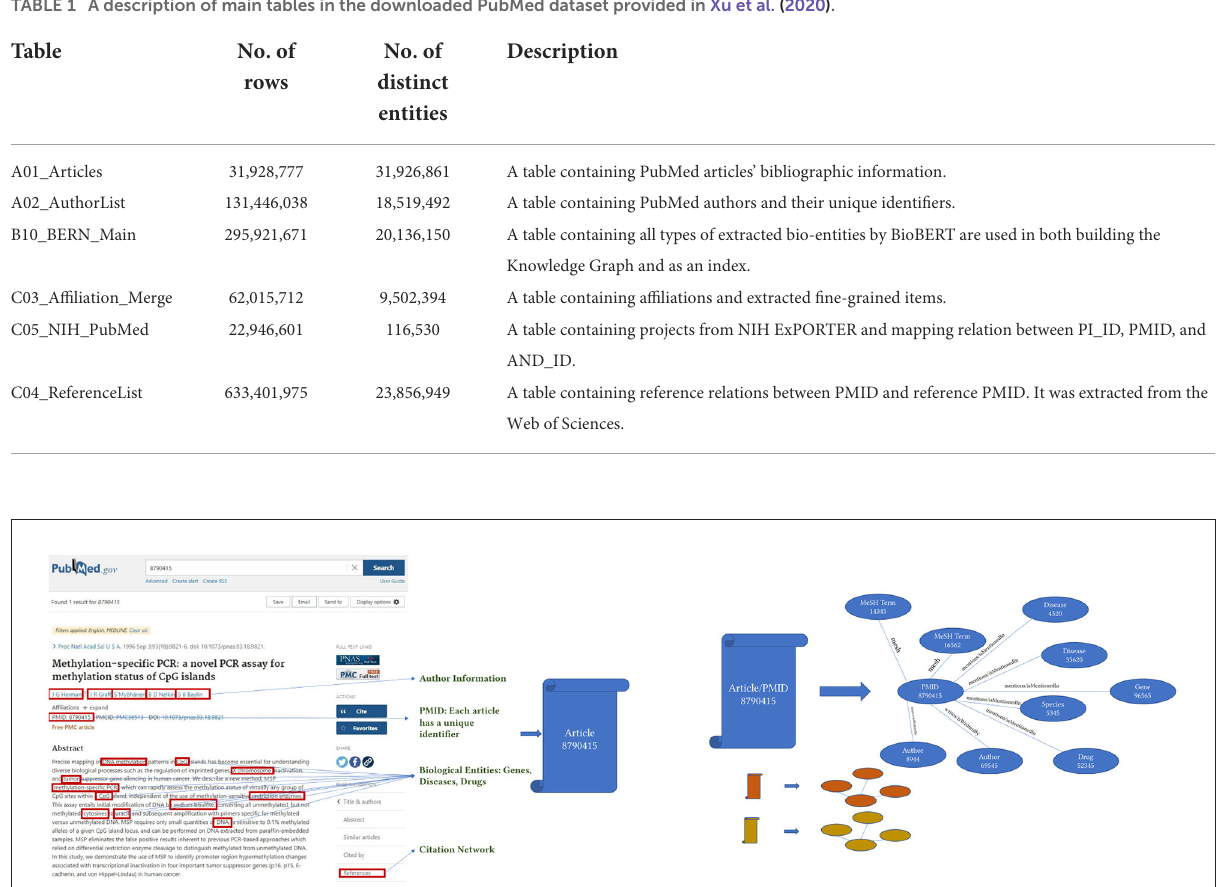
FIGURE2 The image represents how each article is converted to a concept graph or a smaller knowledge